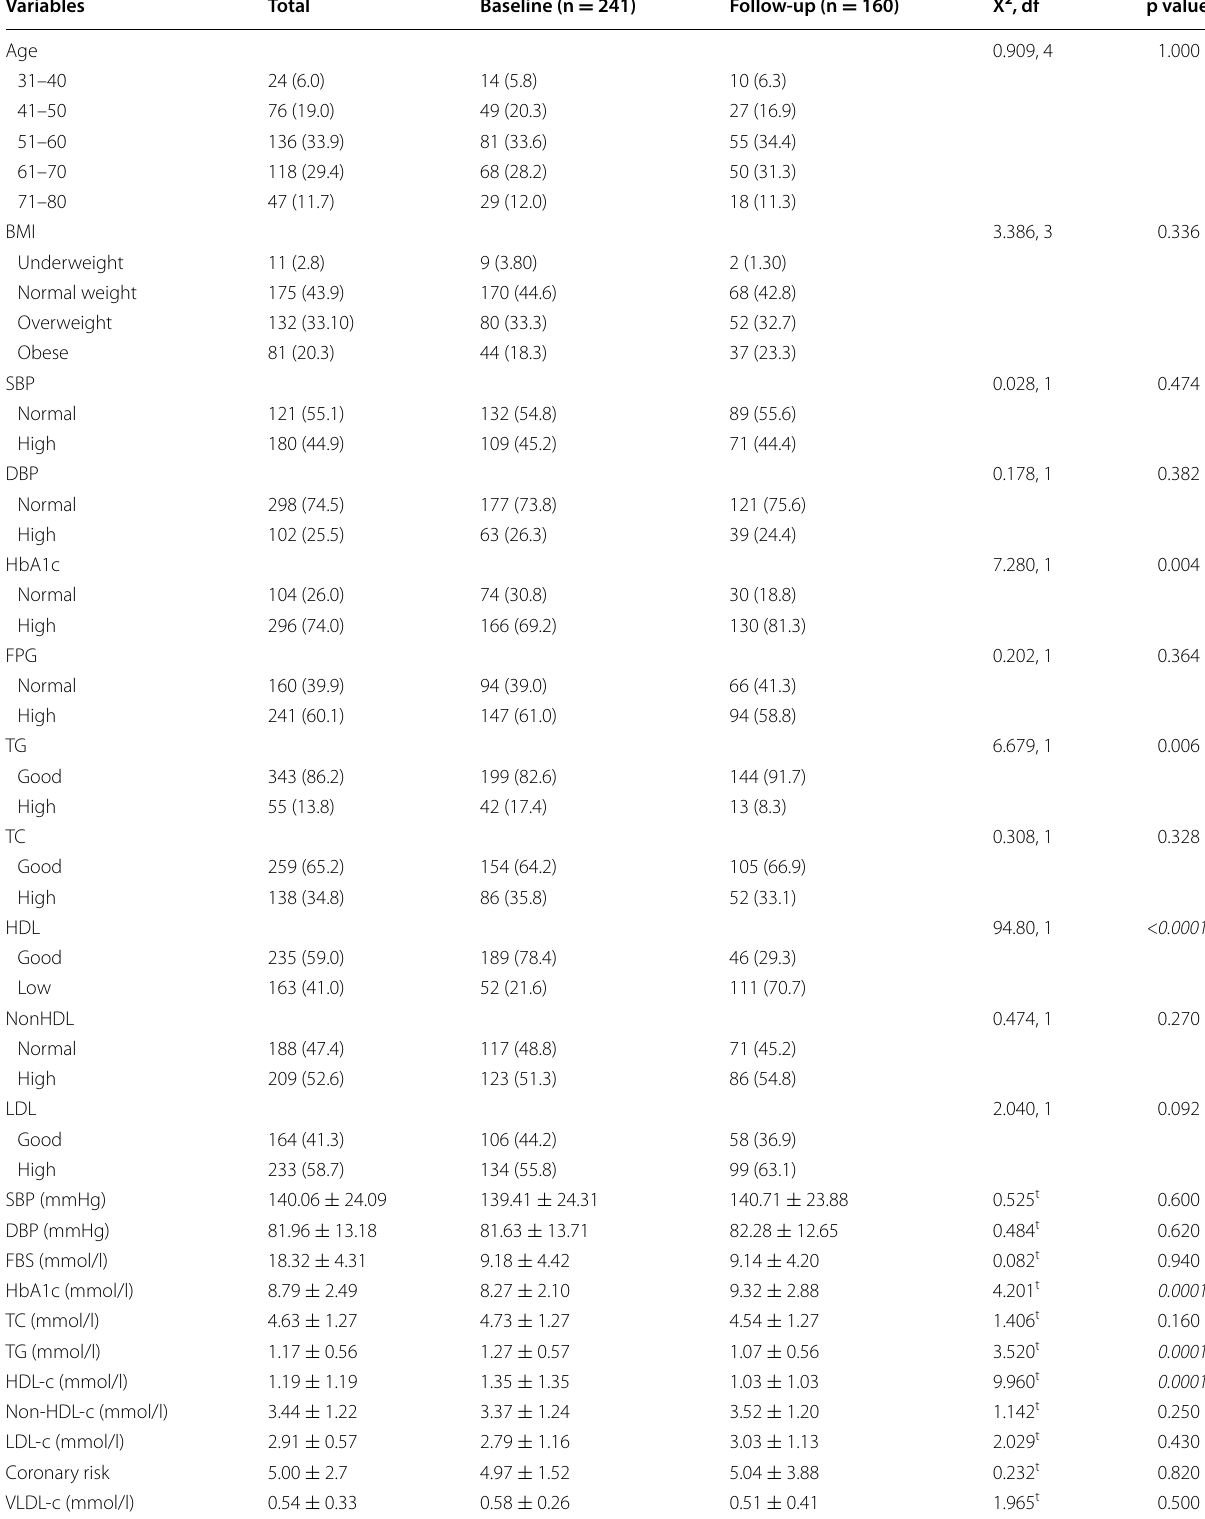
Table 2 Distribution of clinical characteristics among study